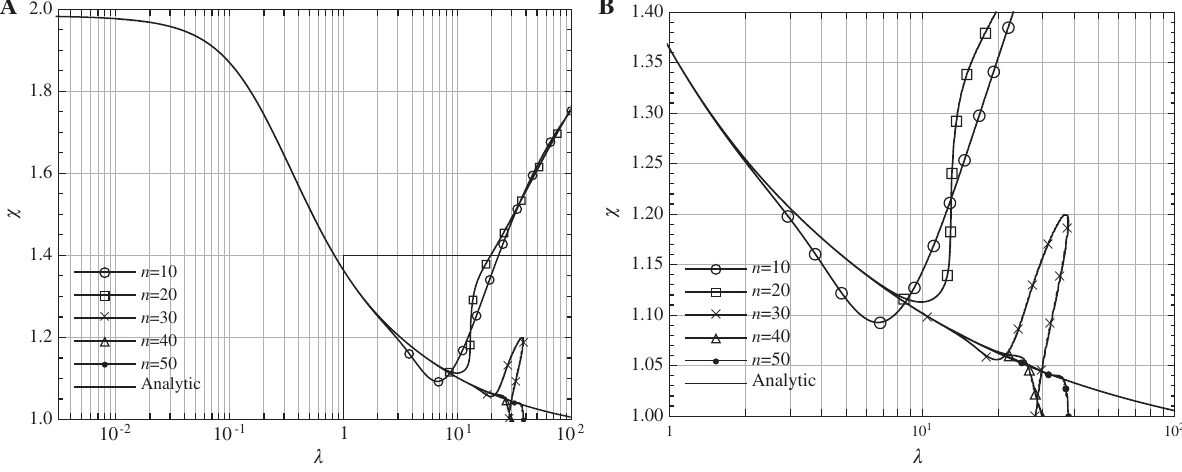
Figure 4: Dispersion curves corresponding to an inhomogeneous MEE layer with profile P2 ( n = -2) on homogeneous substrate for unity dimensionless depth of the layer β h = 1 for various numbers of series terms, n , (A) 4 × 10 -3 < λ < 10 2 , (B) 1 < λ < 10 2